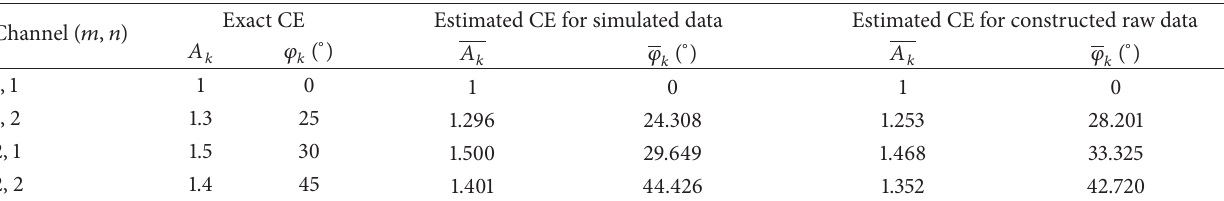
Figure 7: Simulation results for OFDM-MIMO SAR. (a) Imaging result without correction of channel imbalance. (b) Imaging result with correction of channel imbalance. (c) Range comparison of the amplification of the point target in (a) and (b). Table 2: Channel errors